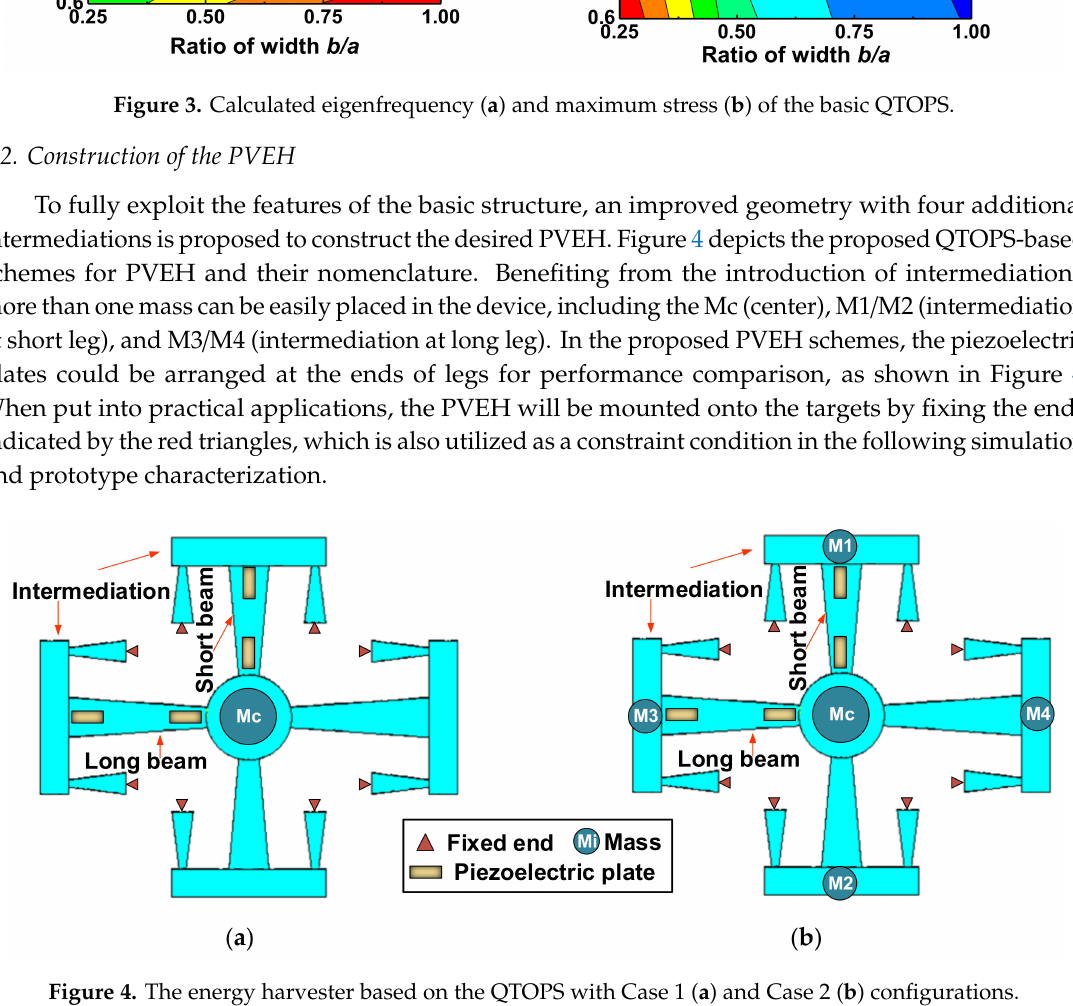
Figure 4. The energy harvester based on the QTOPS with Case 1 ( a ) and Case 2 ( b )